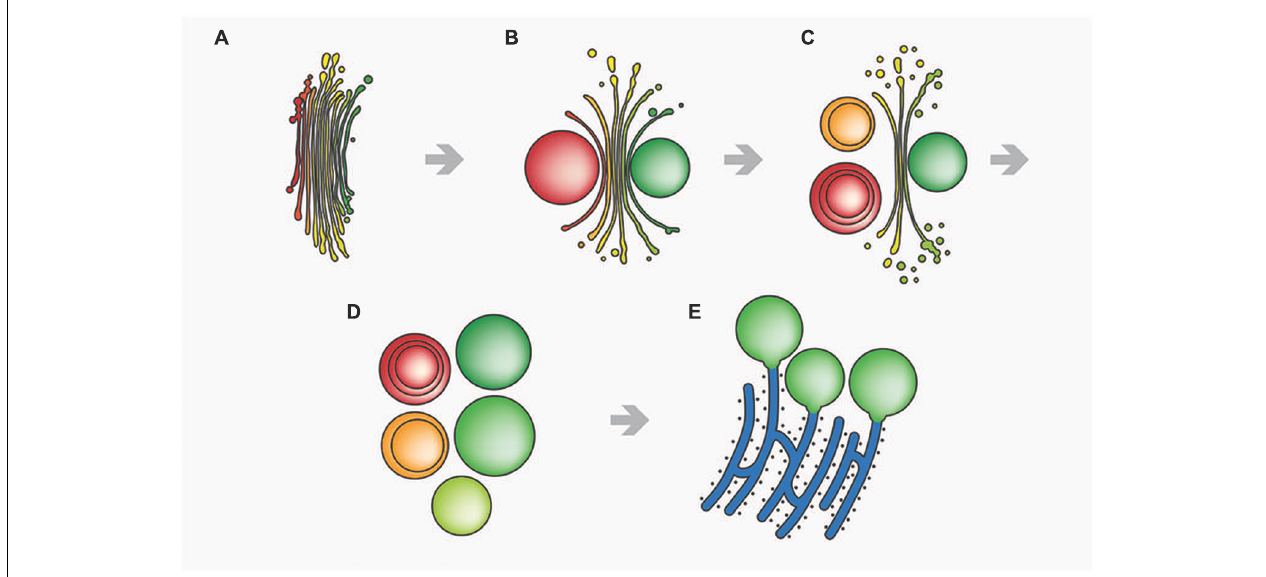
FIGURE 8 | Schematic drawing of stress-induced degradation of dictyosomes in Micrasterias . (A) Control dictyosome with 11 cisternae ( cis -side in red). (B) Beginning degradation, outermost cis - and trans -cisternae form balls. (C) Proceeding degradation and reduction of cisternal number. Cisternal balls include other cisternal balls. Numerous degradation products are visible close to the degrading dictyosome. (D) Dictyosome has completely disintegrated into balls. (E) The cisternal balls fuse with long, stress-induced ER cisternae. Reprinted with permission from Lütz-Meindl et al. (2015), Copyright © 2015 Royal Microscopical